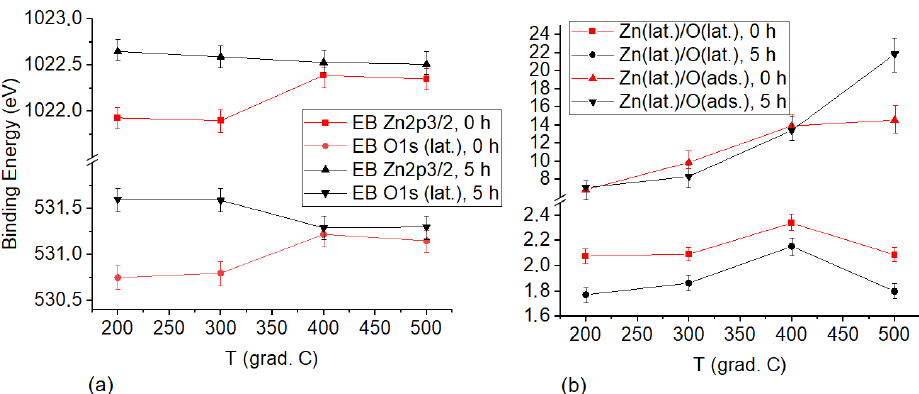
Figure 4. Dependences of the binding energy of Zn 2p3/2 and O 1s ( a ), and the ratio of Zn( lat .)/O( lat .) and Zn( lat .)/O( ads .) ( b ) for the initial ZnO powders and those milled for 5 h at different annealing temperatures.